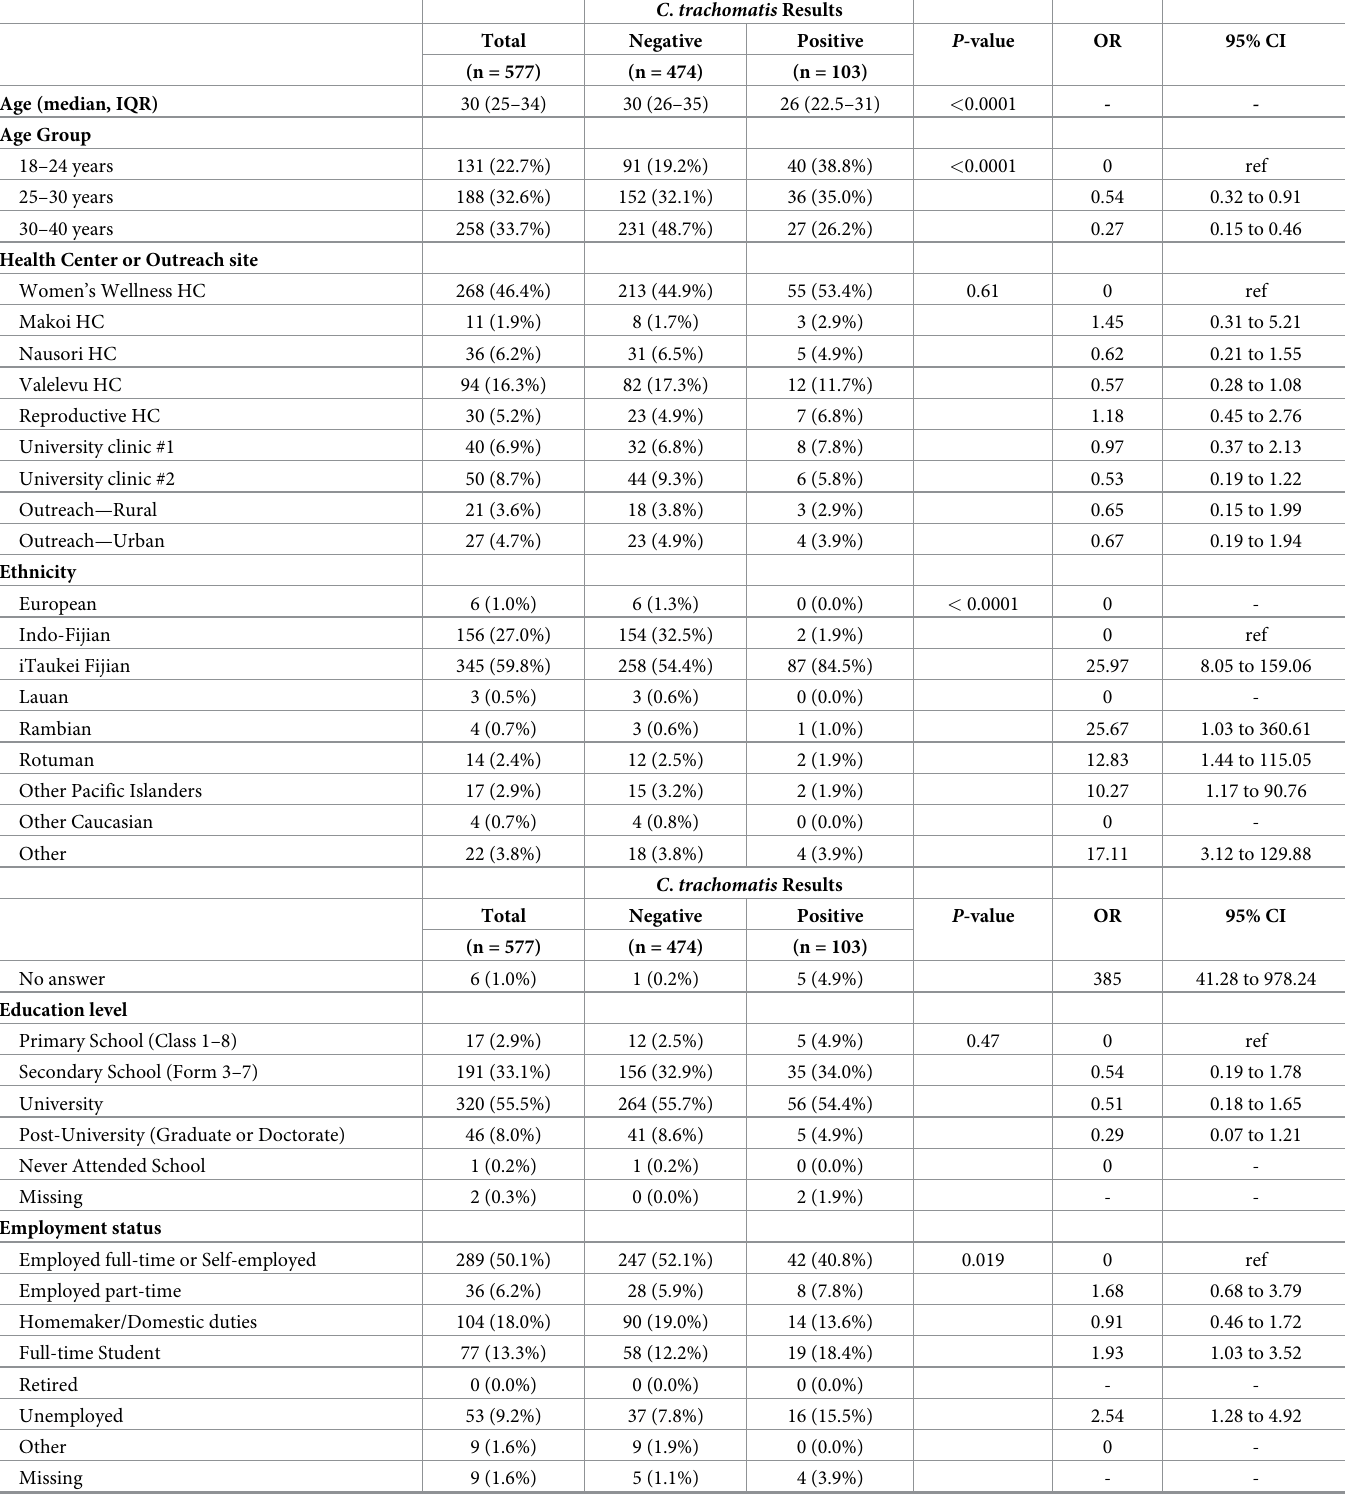
Table 1. Baseline characteristics and bivariate analyses of associations with C . trachomatis